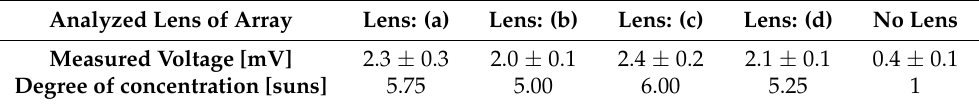
Table 4. Output voltage obtained at PV cells positioned in the focus of each lens of the configuration illustrated in Figure 10b. Analyzed Lens of